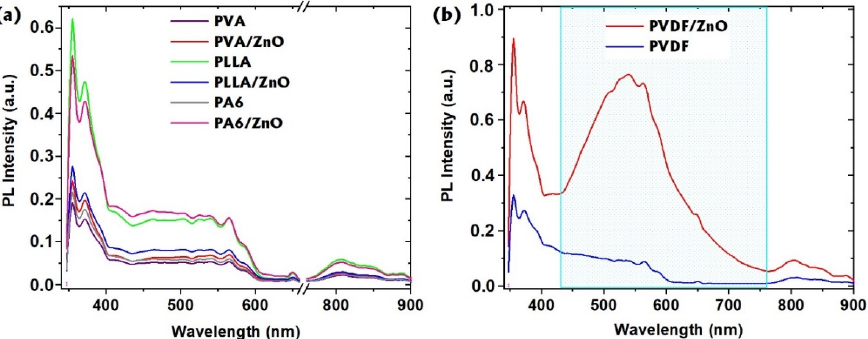
Figure 5. Room temperature PL of the pristine polymers nanofibers and ( a ) PVA/ZnO, PA6/ZnO, and PLLA/ZnO nanofibers; and ( b ) PVDF/ZnO ( λ excitation = 325 nm).